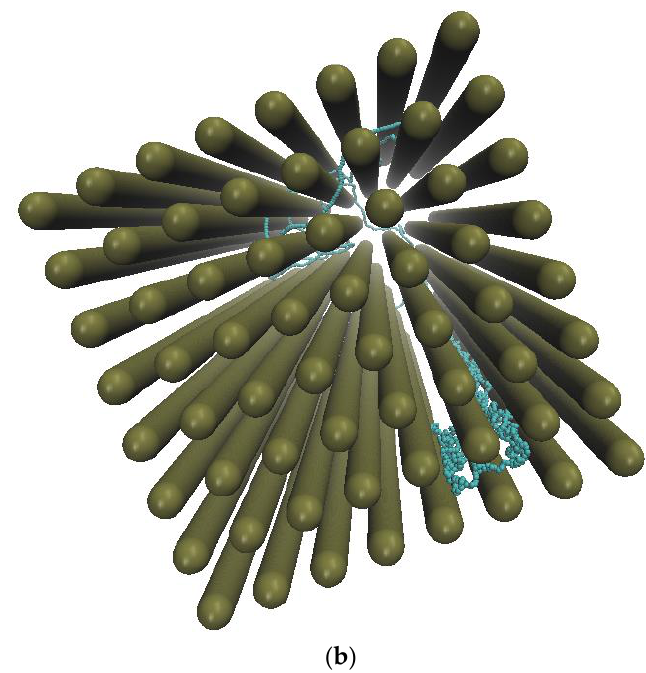
Figure 1. Definition of the parameters characterizing the square-lattice arrangement of the nanoposts illustrated in the cross-sectional view, the Cartesian coordinate frame depicts the orientation of nanoposts. S p is the separation of two adjacent nanoposts, d p is the effective diameter of nanoposts, w p = S p − d p is the closest distance between the walls of two adjacent nanoposts, i.e., the passage width, and d c = √2 S p − d p is the diameter of a quasi-channel, which serves as a gauge for the size of the interstitial space embraced by four neighboring nanoposts ( a ). Cross-sectional view of a flexible chain confined in the nanopost array of S p = 12 ( b ).